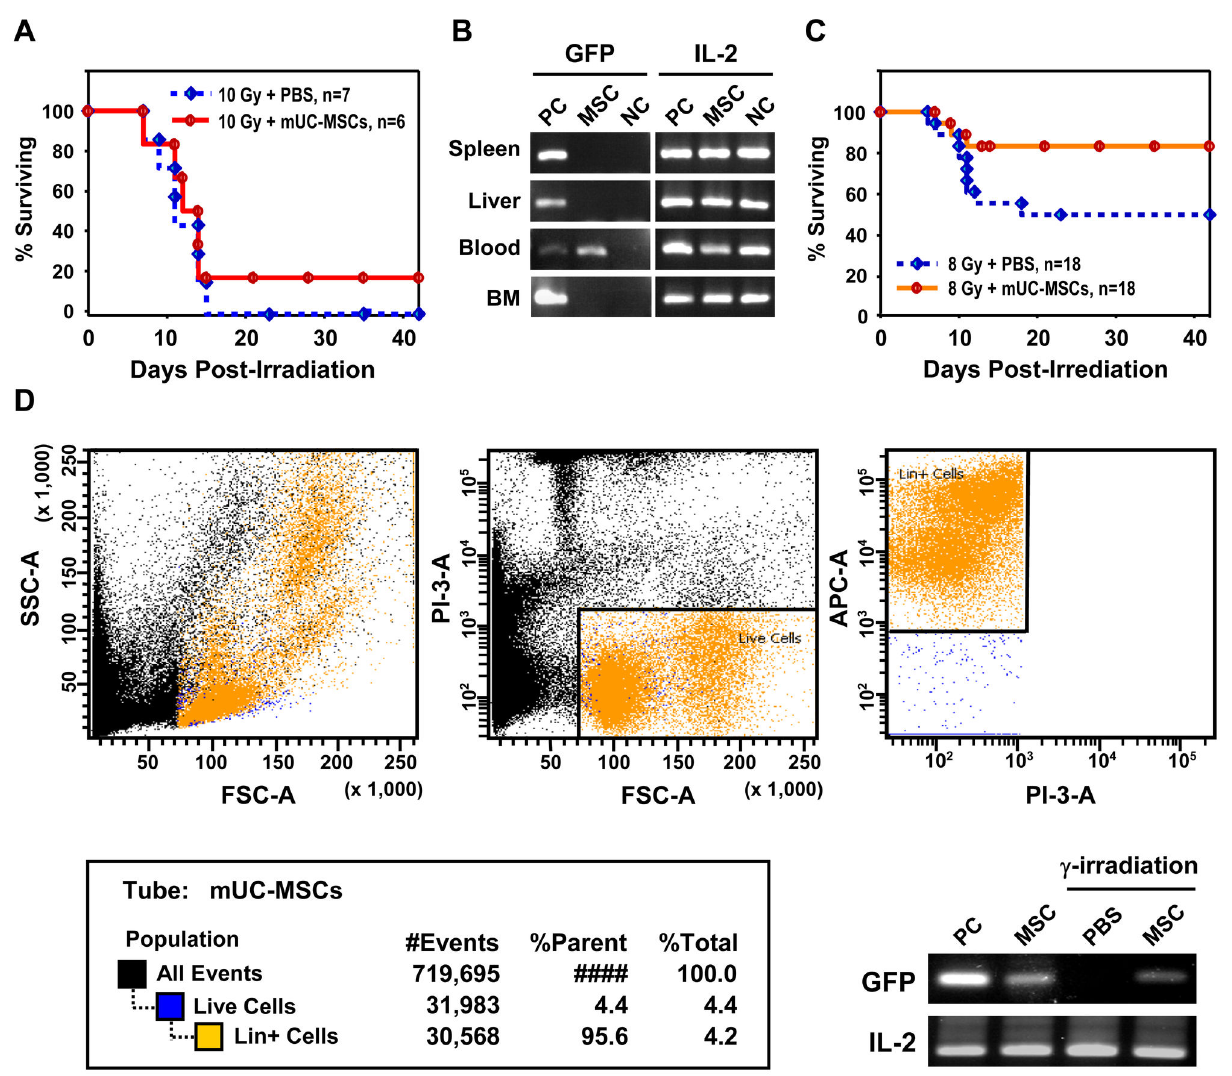
Figure 5. mUC-MSCs transplantation improves mice survival after hematopoietic reconstitution. (A) The C57BL/6JNarl mice were subjected to a lethal dose of 10 Gy γirradiation, and administered 5 × 10 6 cells of GFP-mUC-MSCs (n = 6) or PBS control (n = 7) via tail vein injection 24 hr later. The survive rate of the recipient mice was analyzed. (B) The expression of GFP in liver, spleen, bone marrow (BM), and peripheral blood (PB), was analyzed 6 months post-transplantation by genomic DNA PCR. The expression of IL-2 serves as internal control. (C) The C57BL/6JNarl mice were subjected to a sub-lethal dose of 8 Gy γ-irradiation and administered with GFP-mUC-MSCs (n = 18) or PBS control (n = 18) via tail vein injection 24 hr later. (D) The hematopoietic lineage cells (Lin + cells) of peripheral blood from mice (n = 6, each group) in (C) were analyzed 6 weeks after sub-lethal irradiation. The isolated Lin + cells were subjected to further extraction of genomic DNA and GFP expression was analyzed by PCR. PC = positive control, the tissues or Lin + cells from GFP-transgenic mice; NC = negative control, the tissues or Lin + cells from wild-type C57BL/6JNarl mice; MSC =